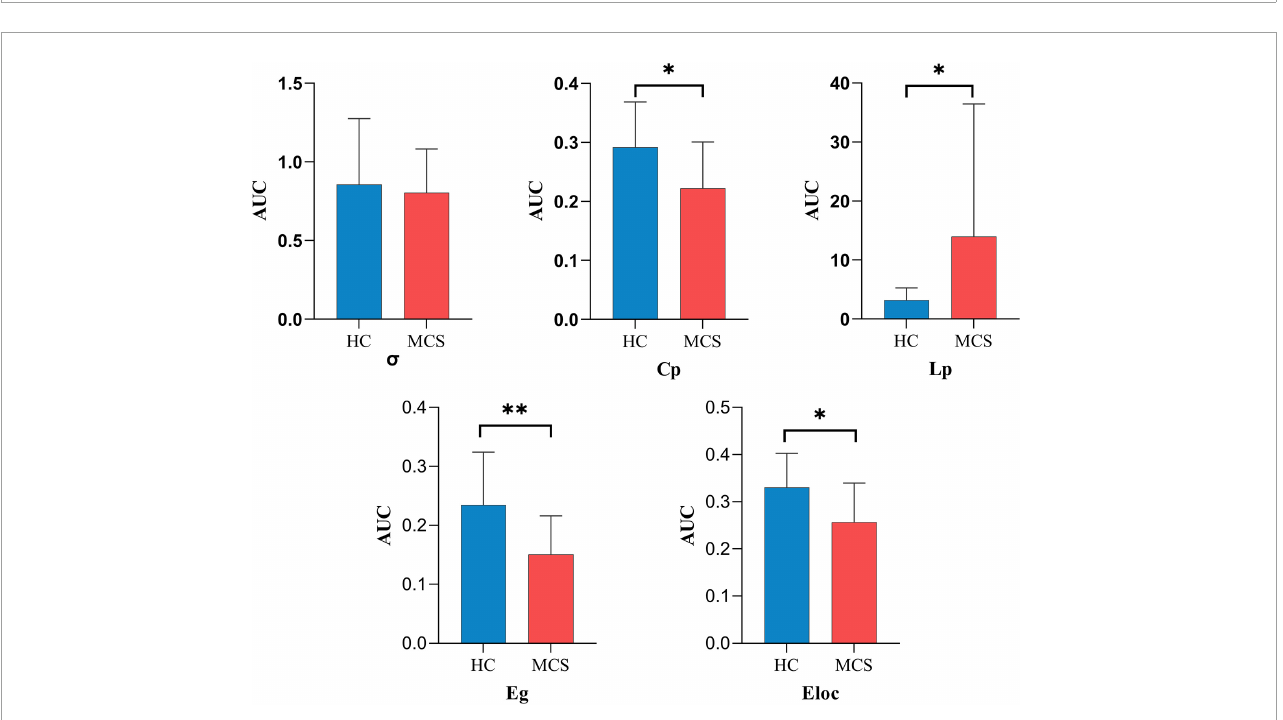
FIGURE4 The global topological properties between HC and MCS groups. AUC, area under the curve; σ , small-worldness; Cp, clustering coefficient; Lp, characteristic path length; Eg, global efficiency; Eloc, local efficiency; HC, healthy controls; MCS, minimally conscious state. ∗ p < 0.05, ∗∗ p < 0.01.